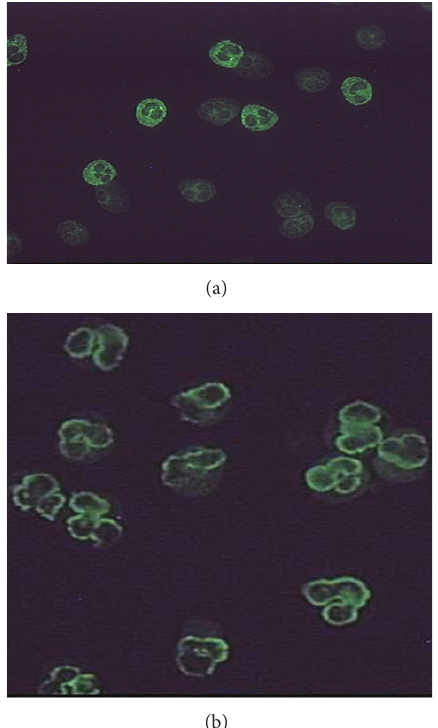
Figure 1: Pattern of immunofluorescence (IFF) staining on ethanol-fixed human neutrophils: (a) cytoplasmic staining pattern (cANCA); (b) perinuclear staining pattern